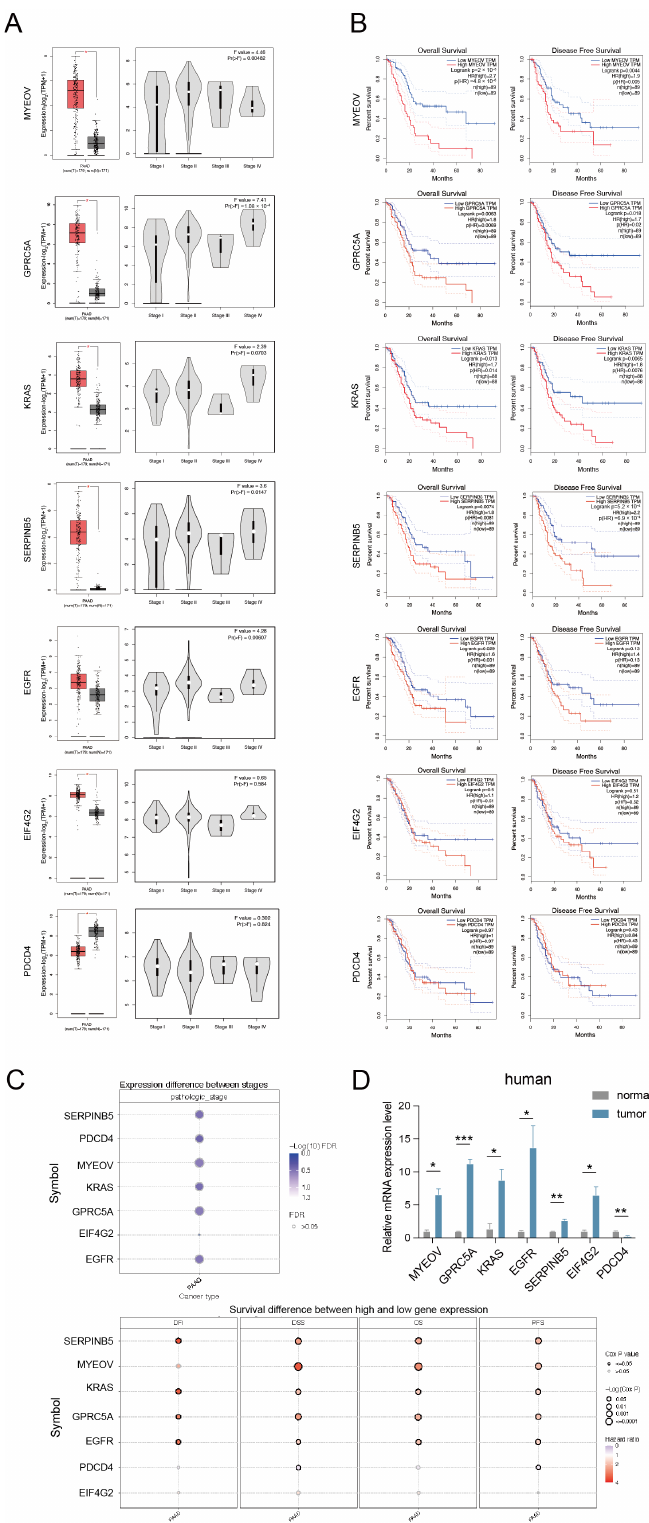
Figure 5. Analysis of the role of related genes in MYEOV regulatory network on pancreatic